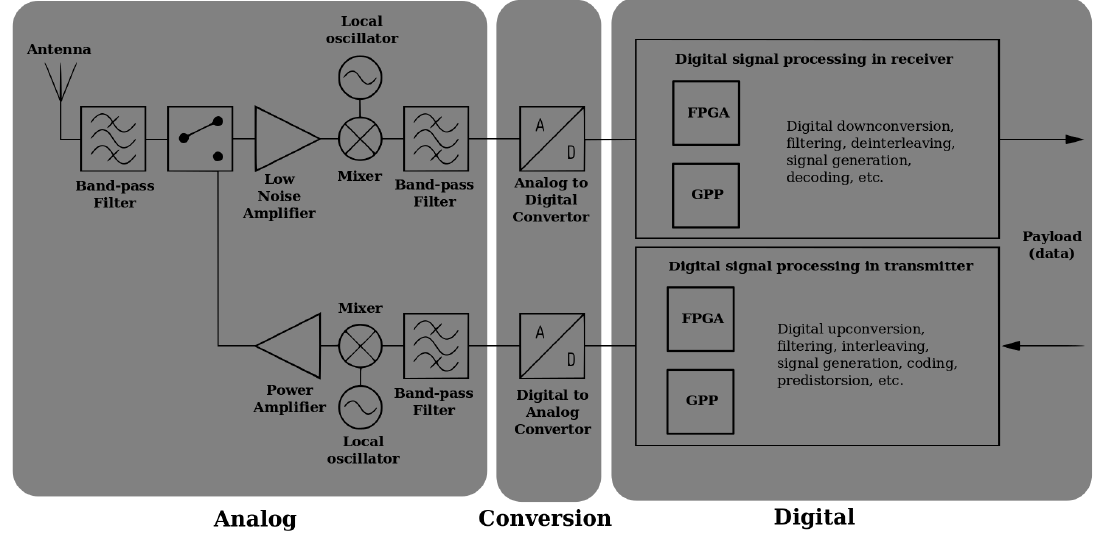
Figure 1. Possible design of a software defined radio. Adapted from